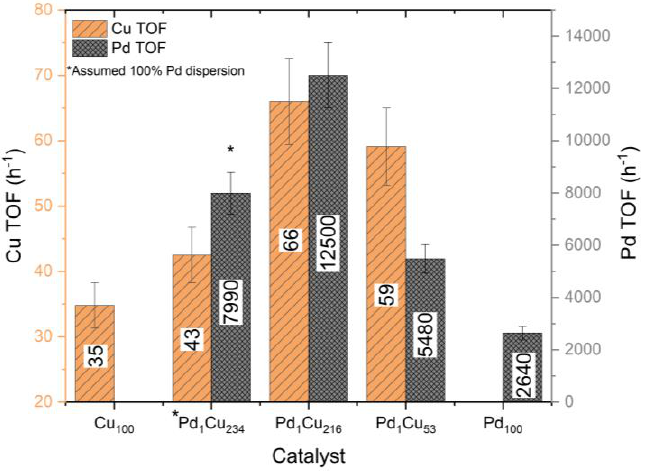
Figure 6. Turnover frequency of both Cu and Pd surface atoms for the catalysts determined from the XPS calculated dispersion for the hydrogenation of crotonaldehyde. Reaction conditions: 7 h, 50 °C, 1.5 bar H 2 , 600 RPM, and 10 mg of catalyst.